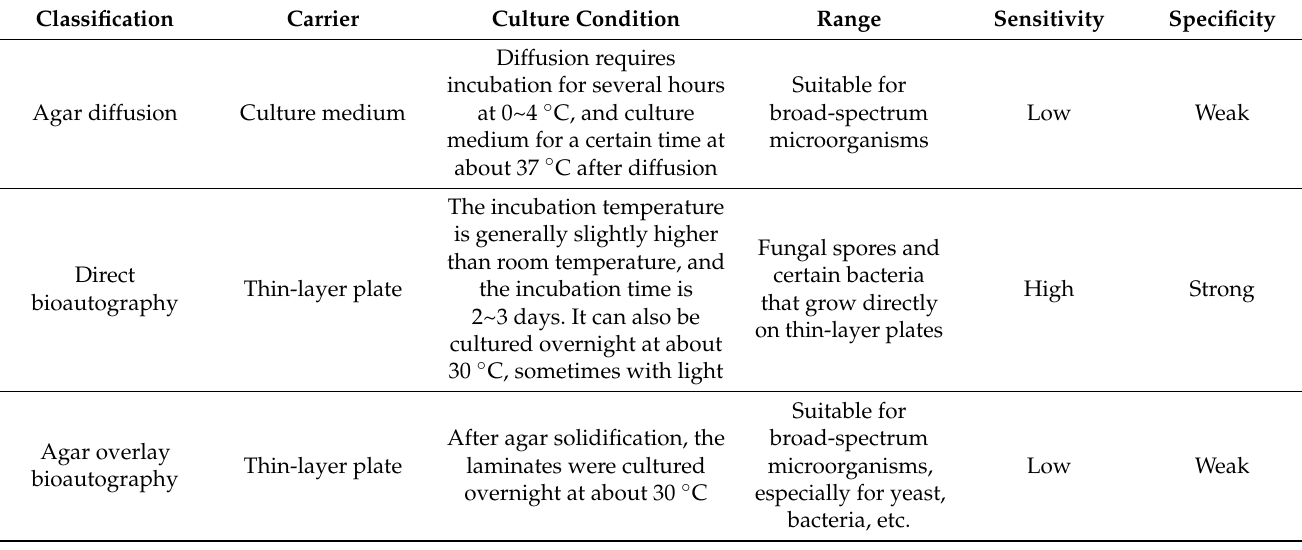
Table 1. The difference between direct bioautography and agar